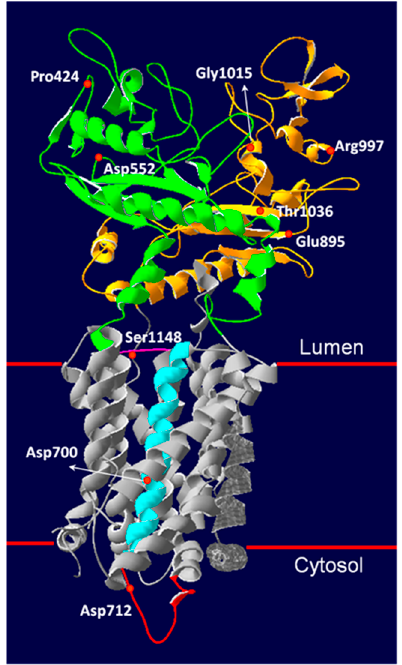
Figure 5. NPC1 protein structure and variants. The structure of NPC1 (PDB 5U73) showed the location of the NPC1 variants identified in this study. Functional domains containing NPC1 variants are indicated in different colors. MLD, middle luminal domain = green; CTD, C-terminal domain = yellow; TM5 = blue; Cytosolic loop = red; lumenal loop between TM5 and TM6 = pink.